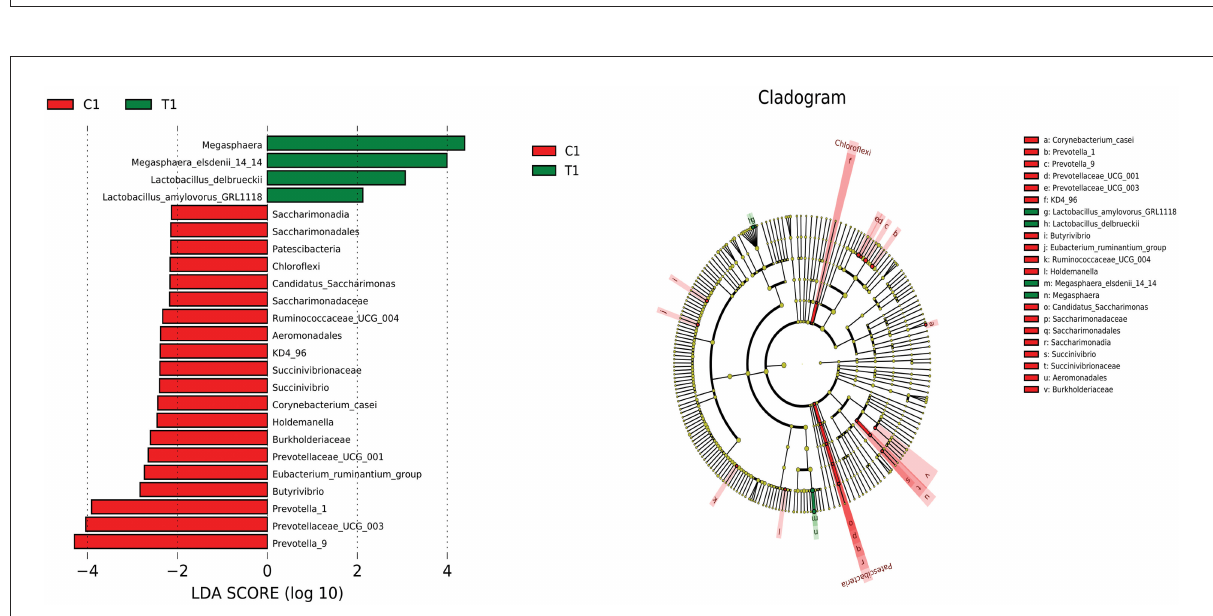
FIGURE6 LEfSe analysis diagram of